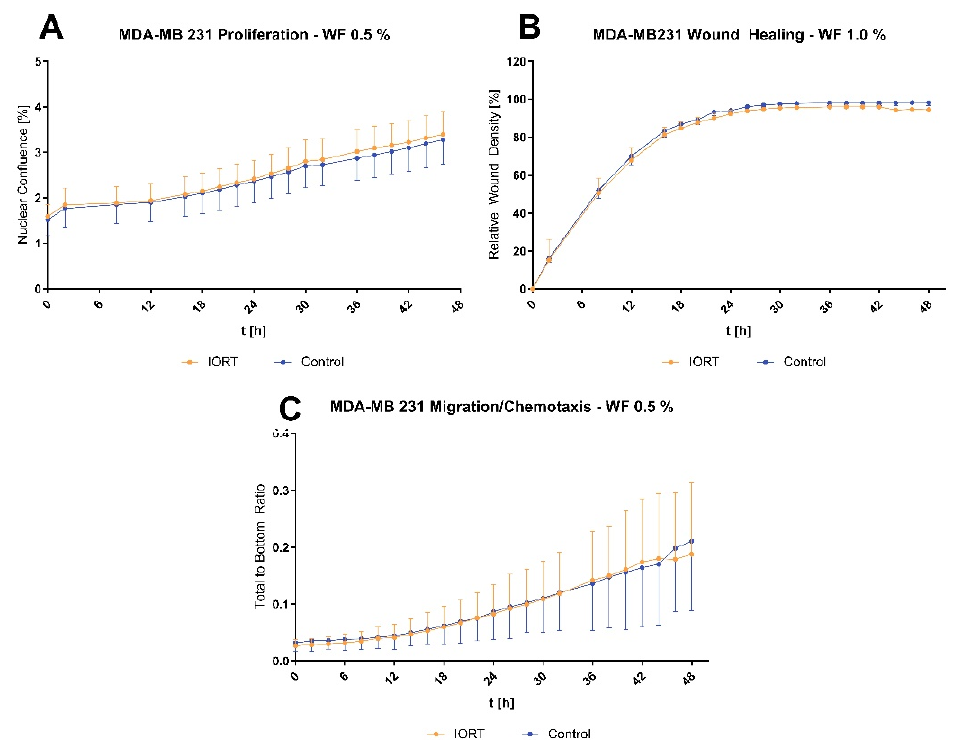
Figure 4. Functional analysis of MDA-MB 231 incubated with 0.5%/1% pooled WF concerning proliferation ( A ), wound healing ( B ) and chemotactic migration ( C ). All assays were reproduced in 3 independent experiments with each 8–12 technical replicates in each condition. Indicated values: mean ± standard deviation in percent over time. Statistical analysis by